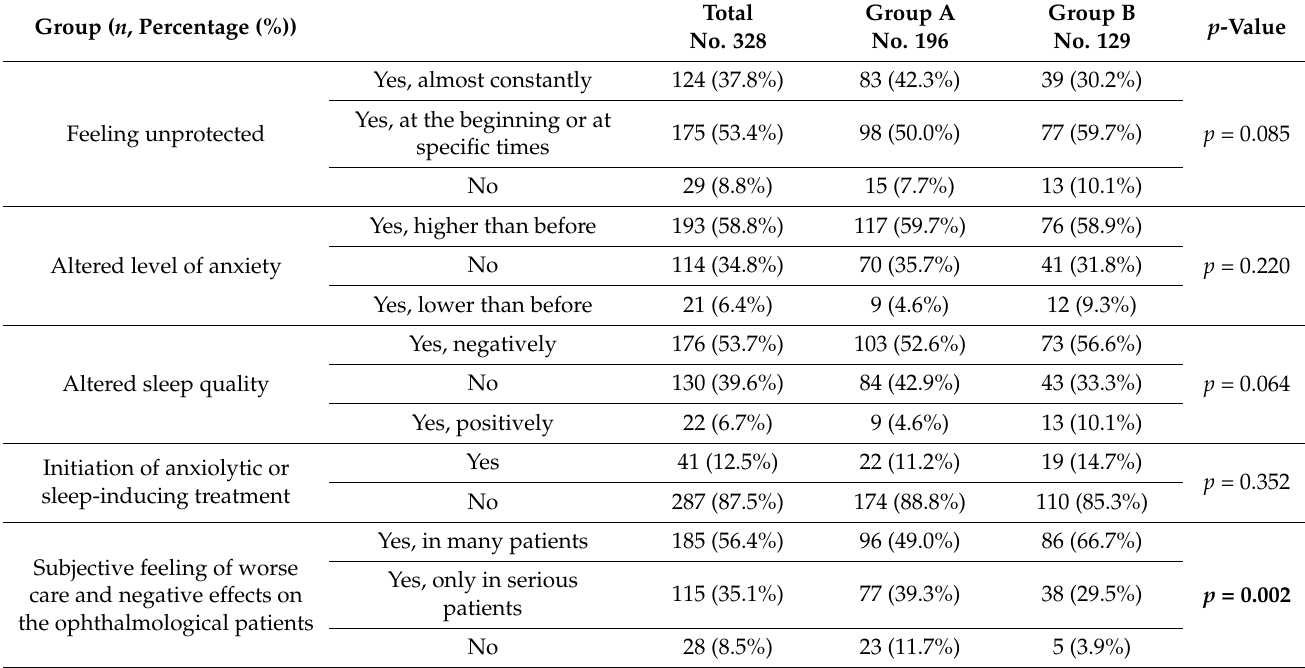
Table 3. Impact of COVID-19 on mental health.